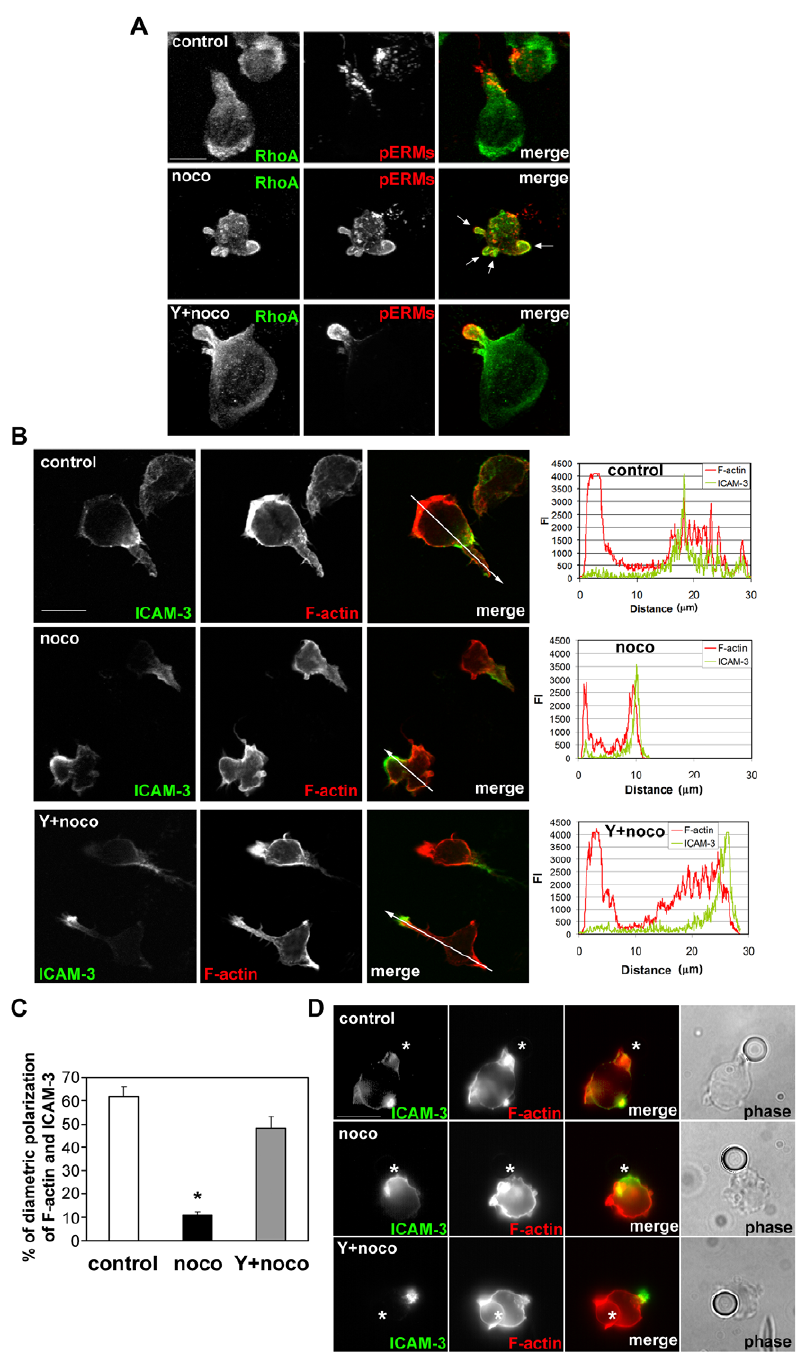
Figure 8. Y-27632 restores migratory polarity to nocodazole-treated cells. (A) CCRF-CEM cells were treated with or without 10 m M Y-27632 (Y) and 20 m M nocodazole (noco) then plated on ICAM-1 and stimulated with 20 nM CXCL12 for 5 min. Cells were fixed and stained with anti-RhoA antibody (green) and anti-phospho-ERM antibody (red). Representative confocal projection images reconstructed from z-stacks of 15 to 25 frames with 0.4 m m interval are shown. Note that Y-27632 prevents nocodazole-induced membrane blebbing (indicated with white arrows) and restricts phospho-ERMs to the uropod. Bar=10 m m. (B) Localization of F-actin (red) and ICAM-3 (green) in CXCL12-stimulated CCRF-CEM cells on ICAM-1. Cells were pre-treated with 20 m M nocodazole (noco) and 10 m M Y-27632 (Y) as indicated. Representative confocal images and line-plot graphs of subcellular distributions of F-actin and ICAM-3 in each condition. Line-plot graphs indicate fluorescent intensity (FI) of phalloidin (F-actin) (red) and ICAM-3 (green) along the white arrows indicated in merge images. (C) Percentage of CCRF-CEM cells with diametric polarization of F-actin and ICAM- 3. Data are from n=220 to 250 cells in each condition which are collected from 3 independent experiments and represent mean 6 SD. *p , 0.03, compared to control cells, Student’s t-test. (D) CCRF-CEM cells were treated with or without 10 m M Y-27632 (Y) for 30 min and subsequently with or without 20 m M nocodazole (noco) for 10 min, incubated with latex-beads coated with ICAM-1 (5 m g/ml) and CXCL12 (20 nM), and then fixed and stained with phalloidin to show actin filaments (red) and anti-ICAM-3 antibody (green). Representative images are shown. Asterisks indicate the bead- cell contact sites.